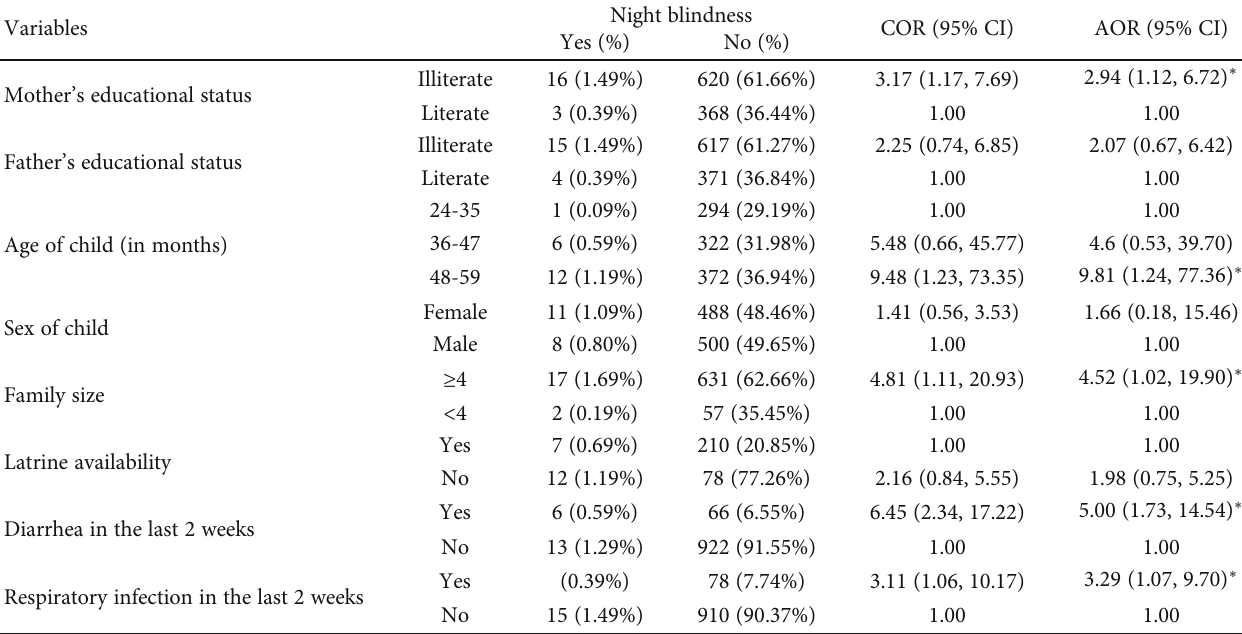
Table 6: Results of bivariate and multivariable logistic regression of night blindness among children aged 24-59 months in Lay Armachiho District, Central Gondar Zone, northwest Ethiopia, 2019.